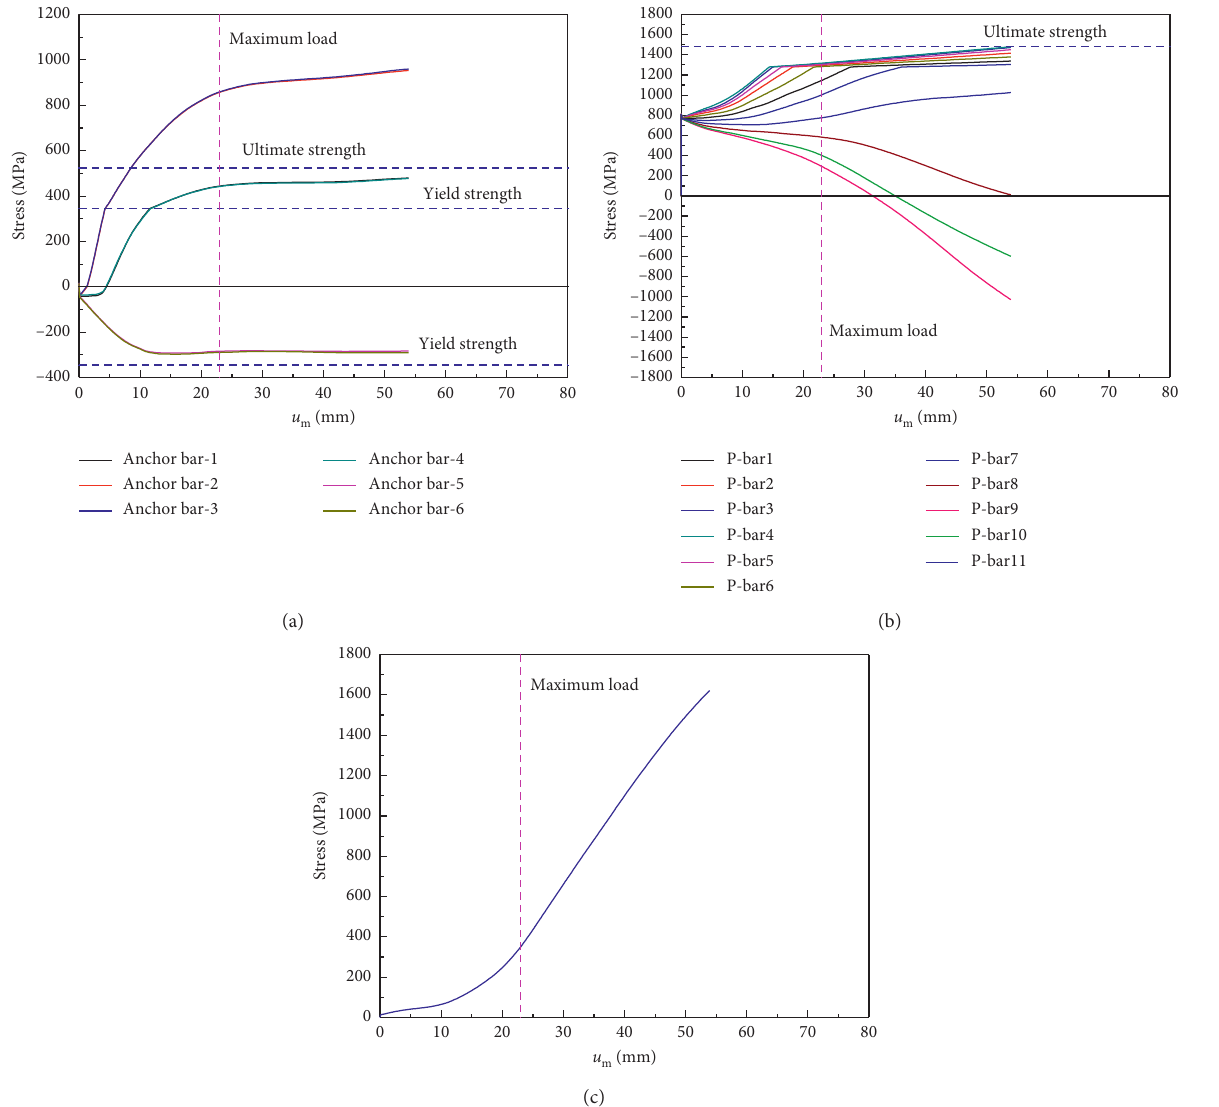
Figure 22: Stress-displacement curves of CT-8. (a) Anchor bar. (b) Prestressed bar. (c)